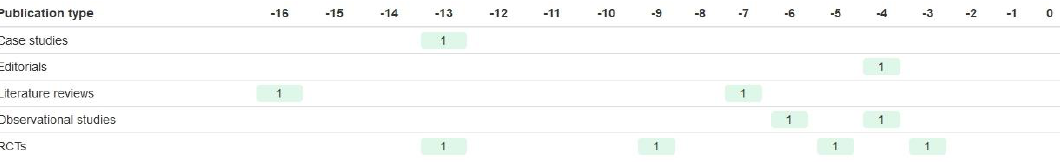
Figure 4. Evidence cited by the SHIVA trial to justify inclusion of the biomarkers, relative to the publication of the 2014 protocol (included in Supplementary of a 2015 paper [43]). RCT = randomised controlled trial.